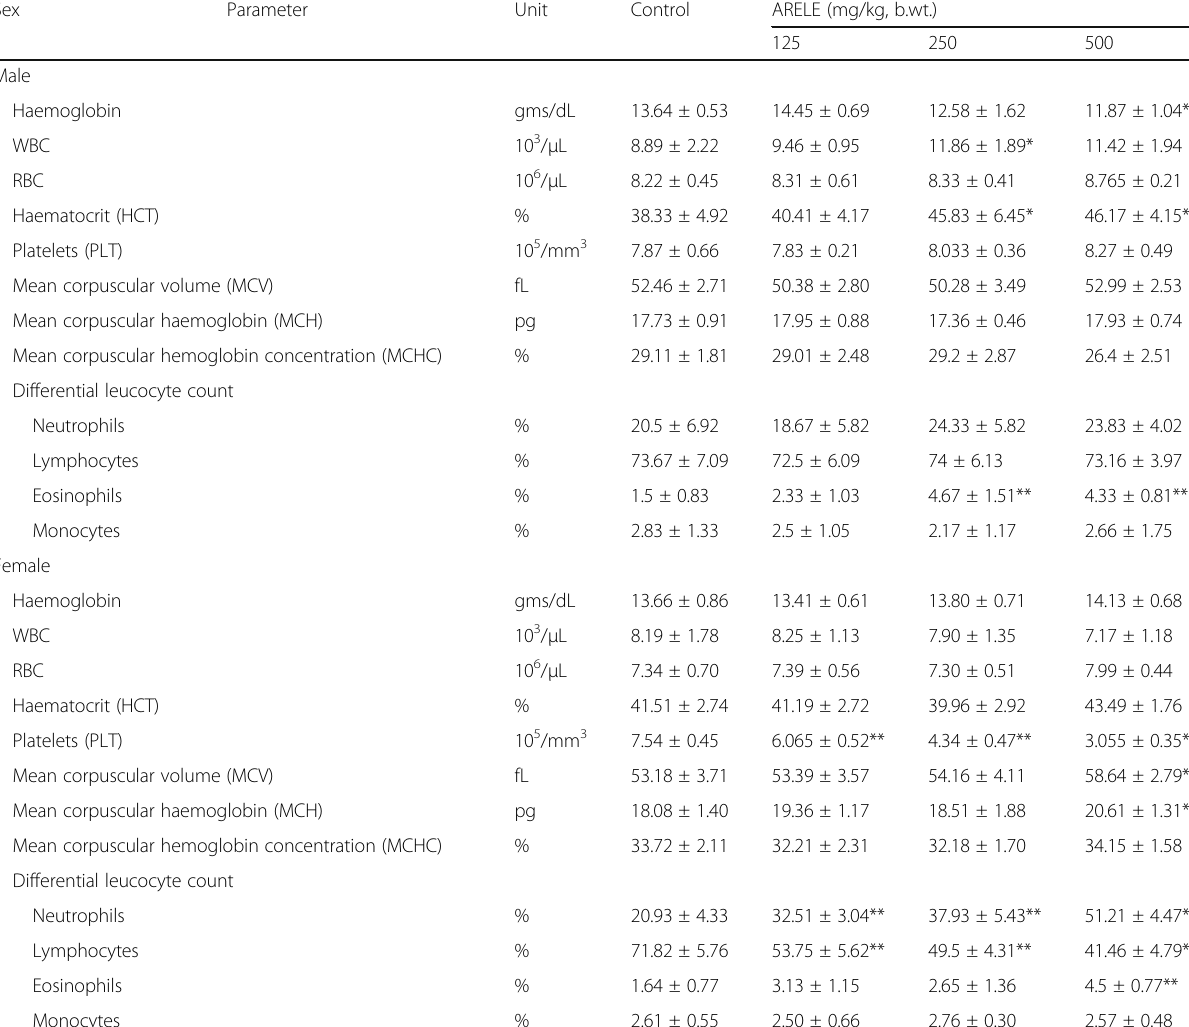
Table 2 Effects of ARELE on haematological parameters in both male and female rats treated for 30 days Sex Parameter